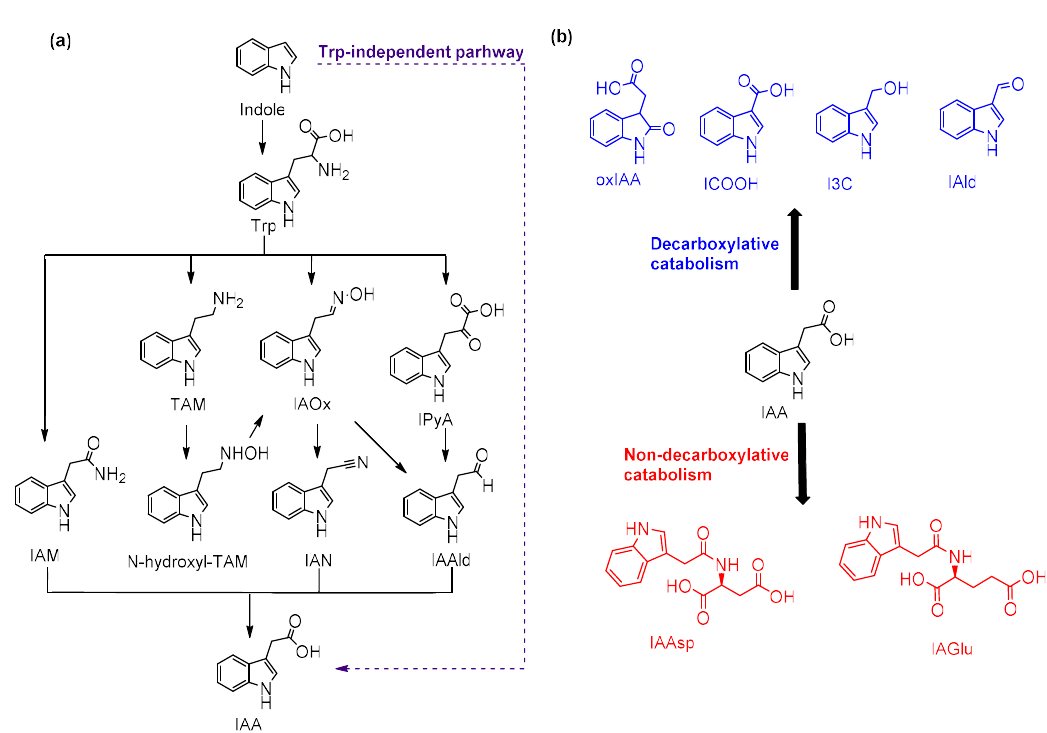
Figure 1. ( a ) Indole-3-acetic acid (IAA) biosynthetic pathways and ( b ) IAA catabolism.